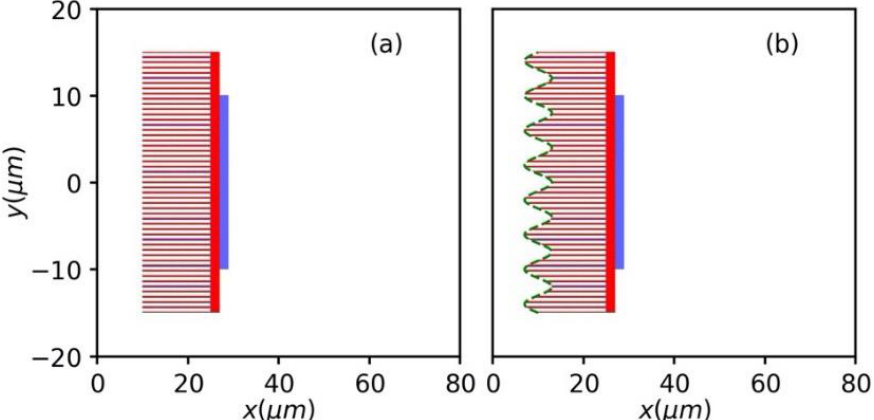
Figure 1. Schematics of the PNT ( a ) and the CNT ( b ). Both targets consist of solid nanowires and substrate of Au 50+ (red part) and a thin hydrogen foil (blue part). The corrugated surface profile is marked by a green-dashed line.